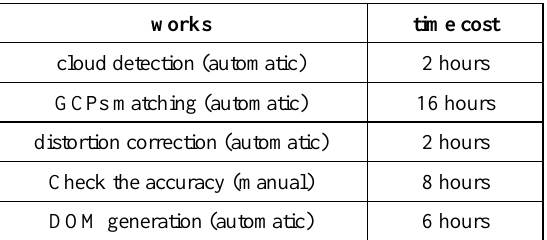
Table 3. Time costs of the processing workflow